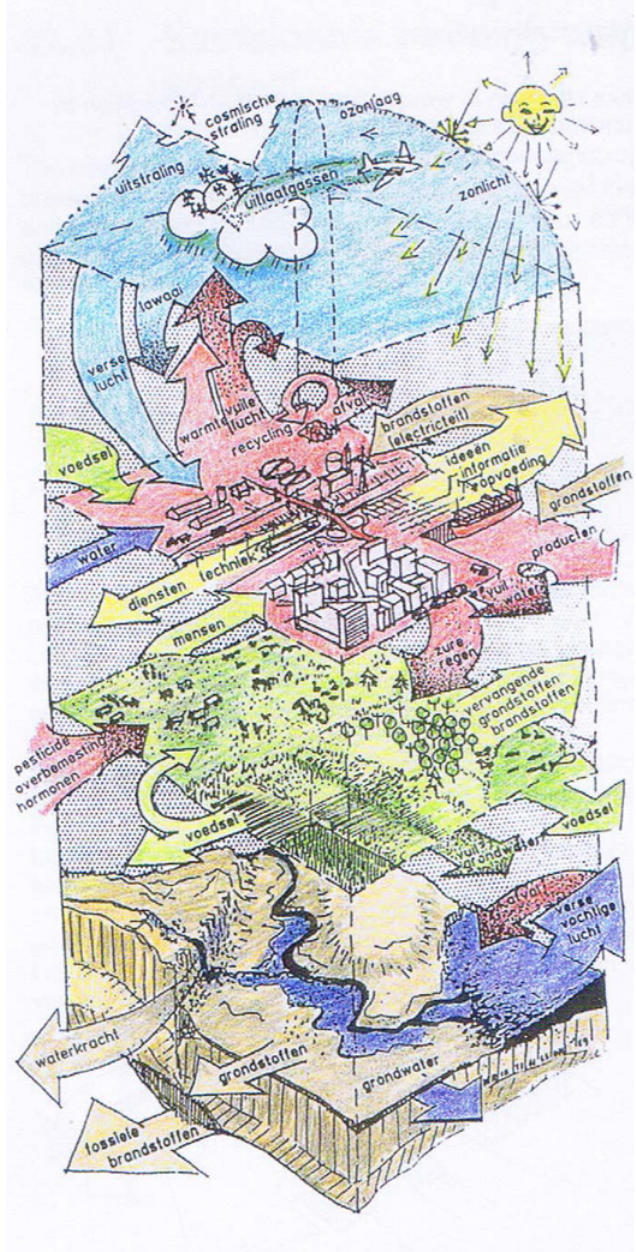
Figure 2. Combining the layer components of the urban system with in- and out-going flows: Kristinsson’s environmental system